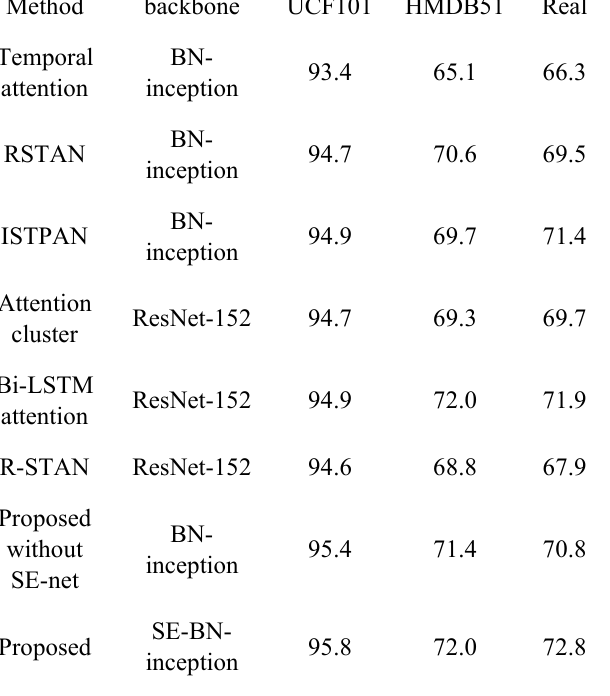
Table 5. Comparison of average recognition accuracy with attention-based